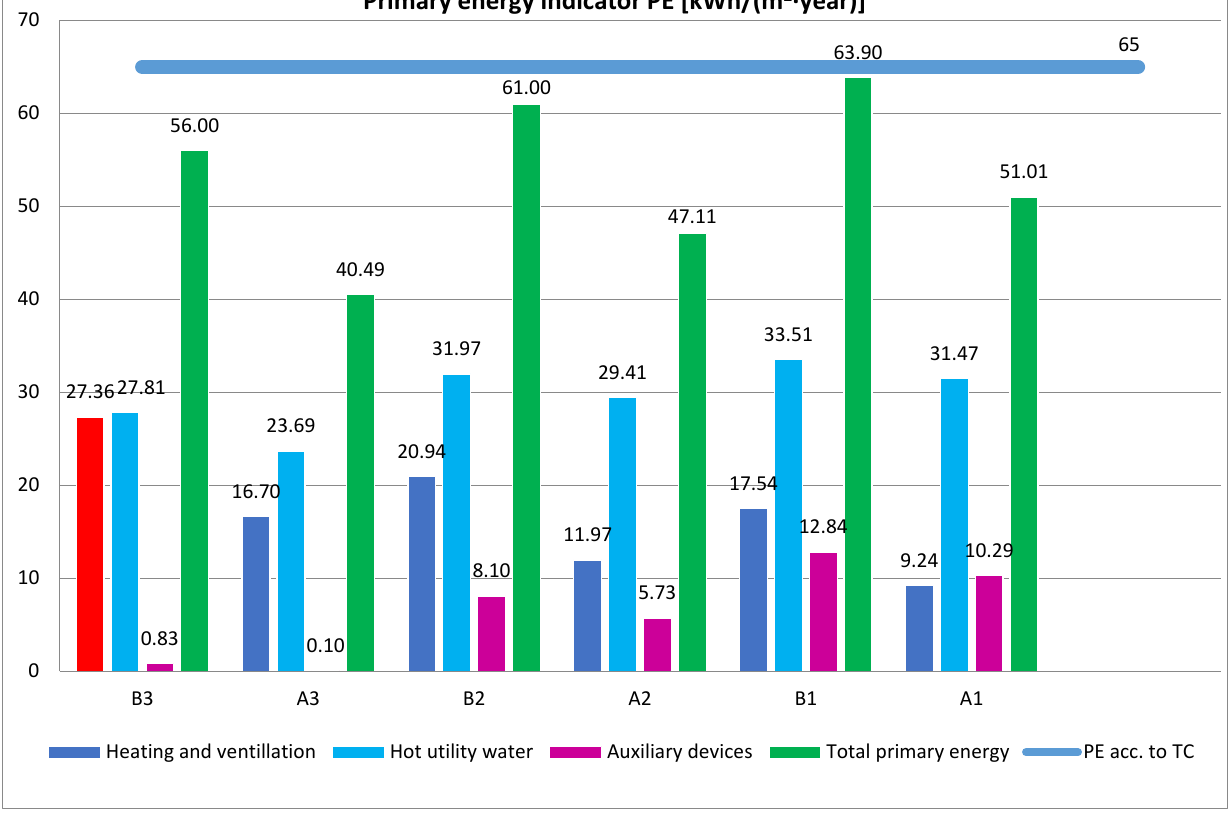
Scheme 5. Comparison of PE for a building of a different energy class for the heat source: the glycol–water heat pump combined with the PV